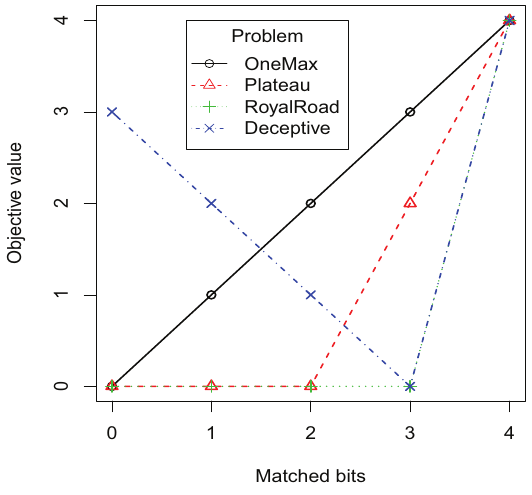
Fig. 2. Fitness contribution of every 4-bits block with re- spect to the number of correctly matched